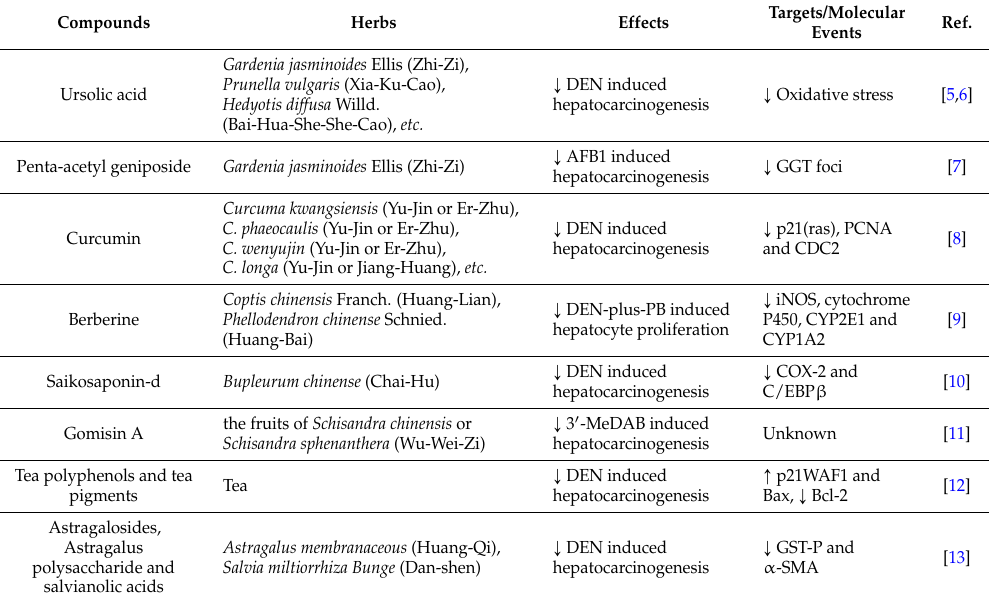
Table 1. Herbal compounds that inhibit hepatocarcinogenesis.